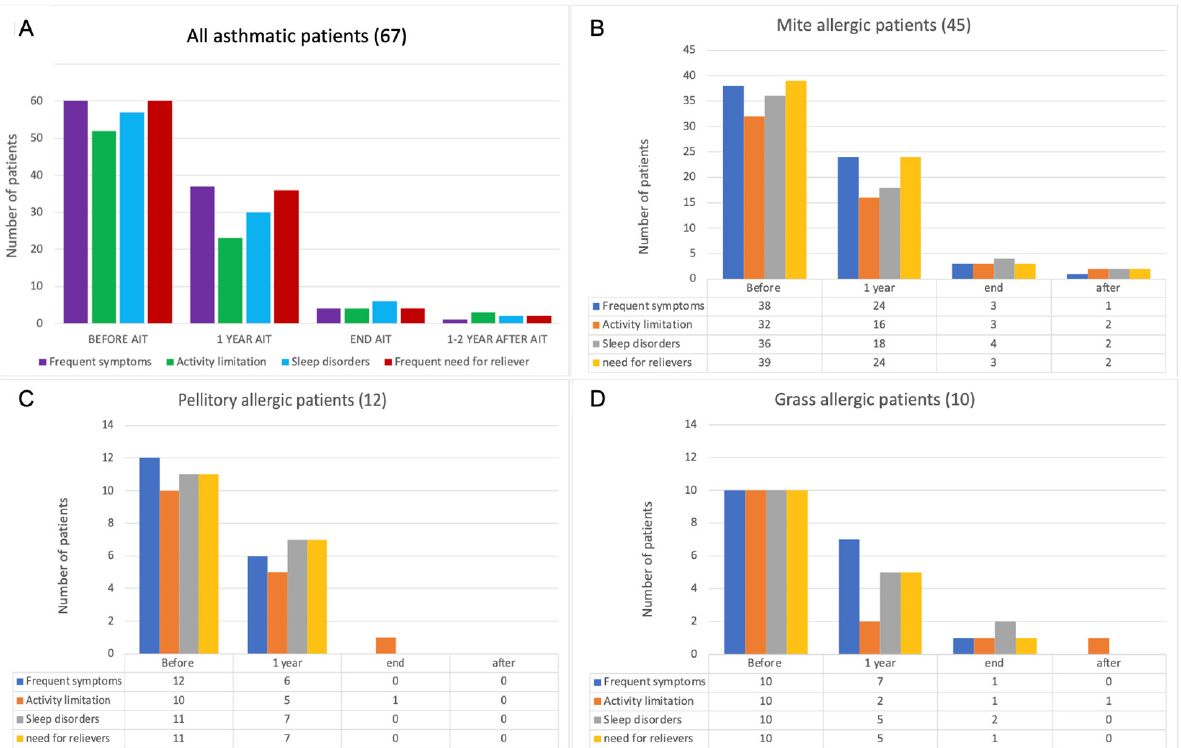
Figure 3. Number of patients with specific symptoms indicative of asthma control. ( A ) all asthmatics, ( B ) mite allergic patients, ( C ) pellitory allergic patients, and ( D ) grass allergic patients.